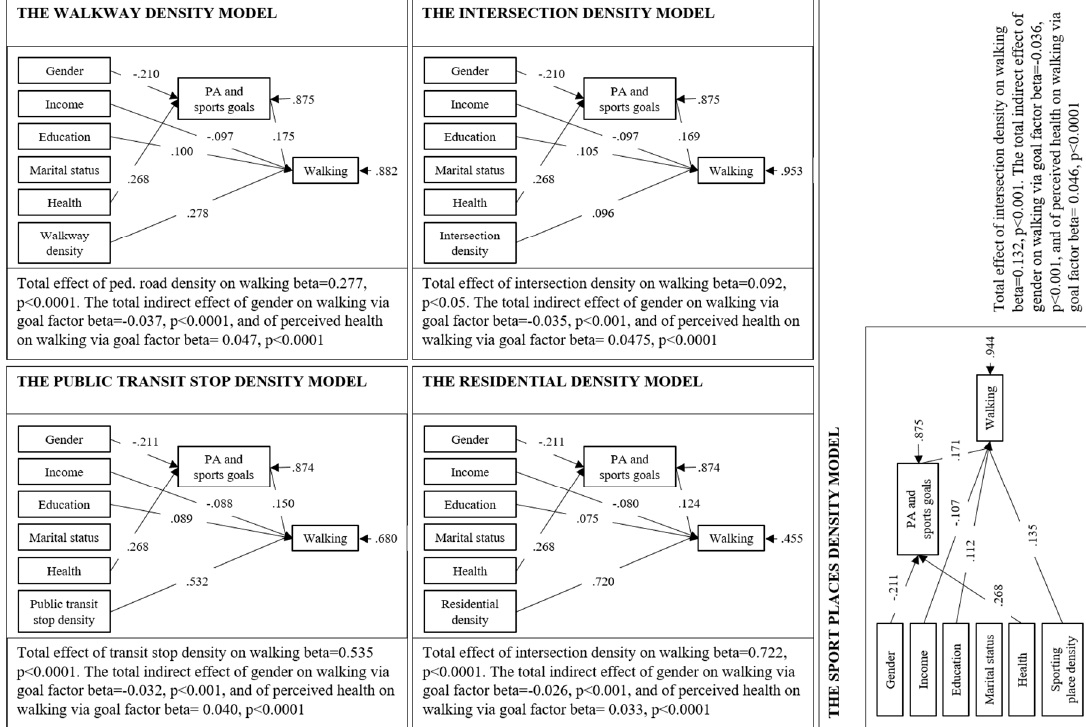
Figure 4. Significant paths with standardized Beta ( β ) for the five different theoretical models. The figure illustrates only the significant paths between different variables.